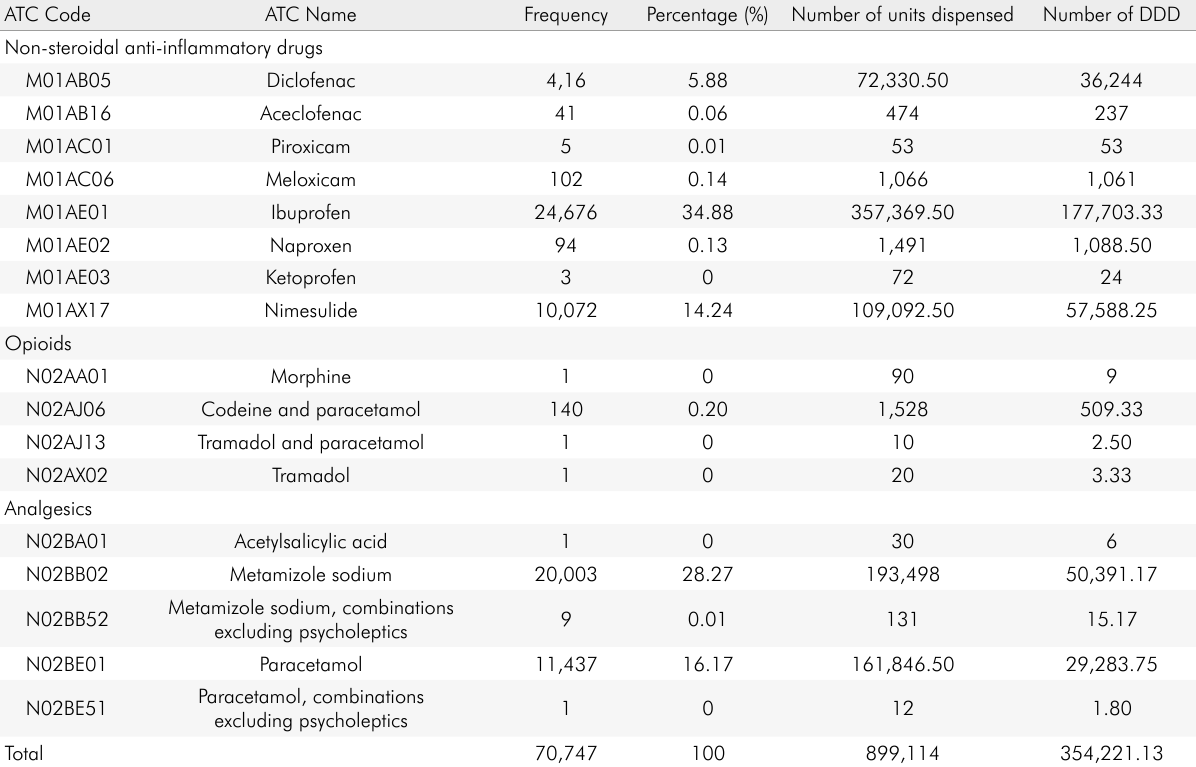
Table 2. Pain relievers dispensed by dental prescriptions in the Brazilian National Health System in the state of Minas Gerais, 2017. ATC Code ATC Name Frequency Percentage (%) Number of units dispensed Number of